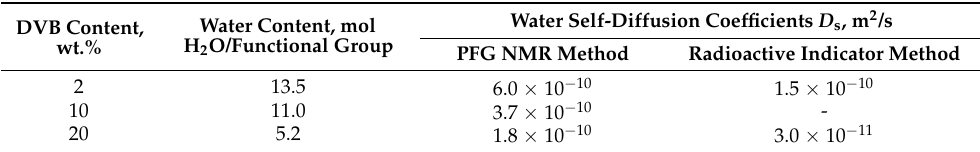
Table 10. Self-diffusion coefficients of water molecules in the Cl − form in MAP-1 membranes equilibrated with water and comprising various contents of DVB.